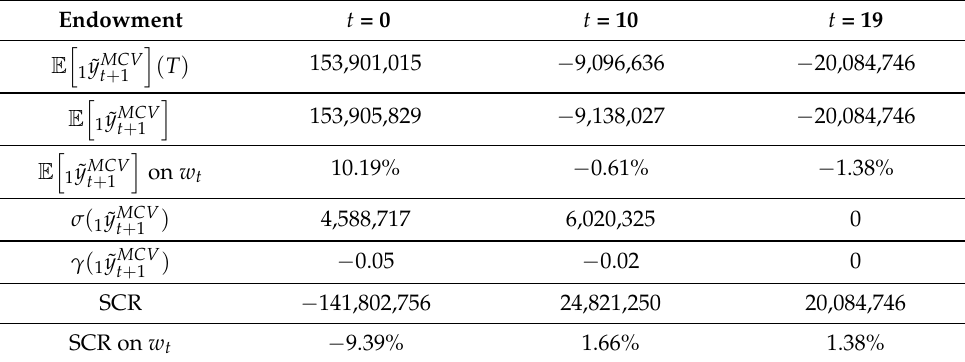
Table 6. Simulated MCV results—Endowment.